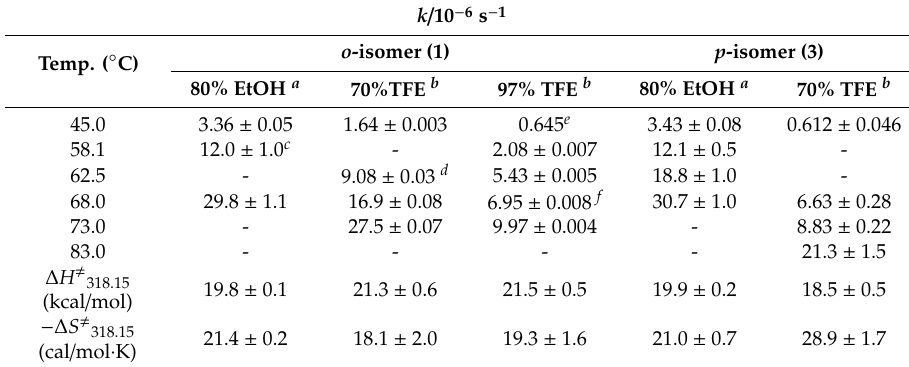
Table 2. Rate constants ( k ) and activation parameters ( ∆ H (cid:44) and ∆ S (cid:44) ) for solvolysis of 1 and 3 in aqueous binary mixtures at various